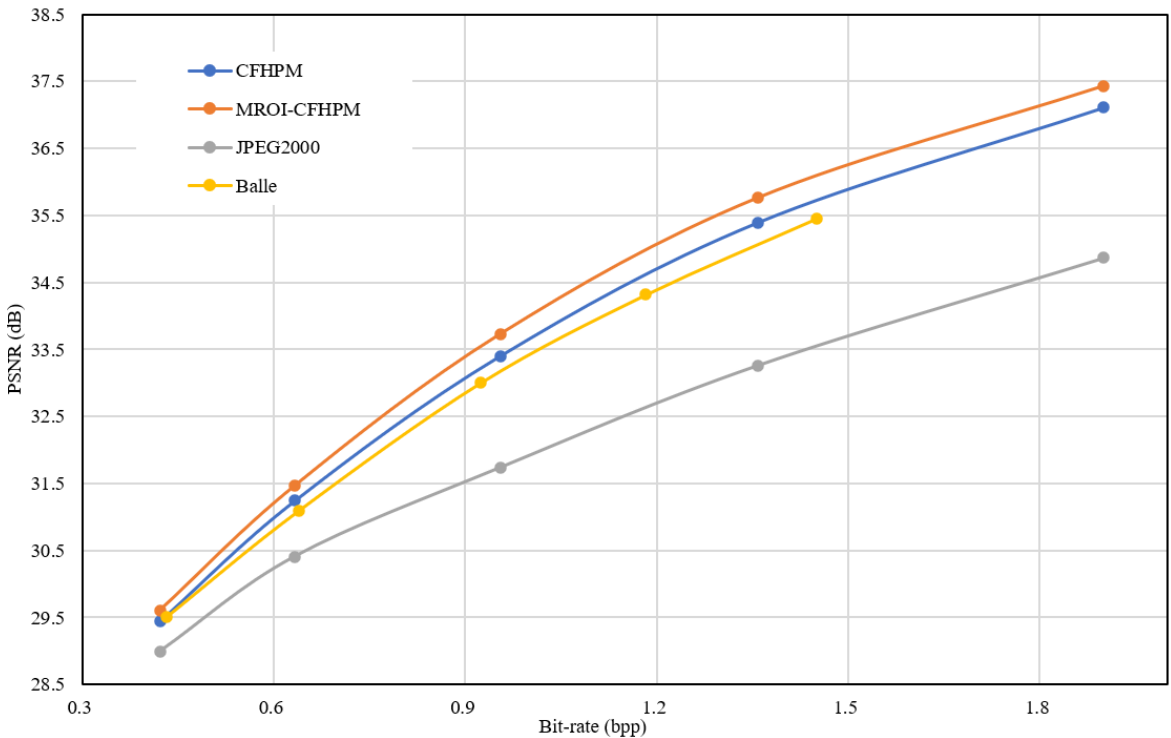
Figure 9. Rate–distortion curves of our proposed MROI-CFHPM against the JPEG2000, CFHPM, and Balle. This PSNR is for the entire image, including noncloud and cloud regions.